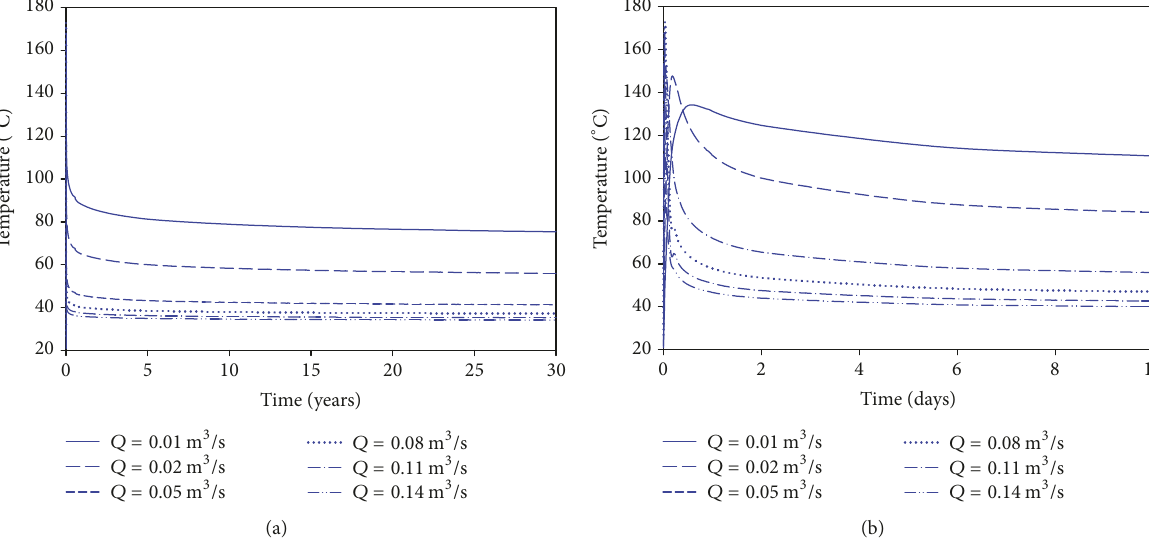
Figure 5: Variation with time of output temperature of the production well under different injection rates when L 1 = 3500 m and L 2 = 6000 m: (a) for general view and (b) for local